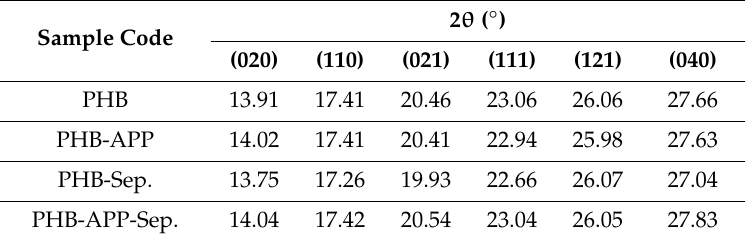
Table 6. Lattice constants and lattice volume of PHB and blends.